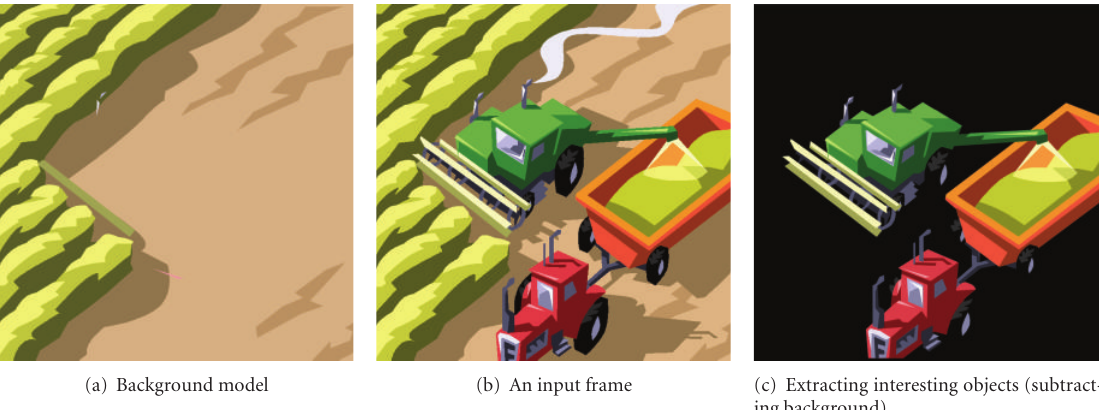
Figure 3: Capturing interesting moving objects using background subtraction